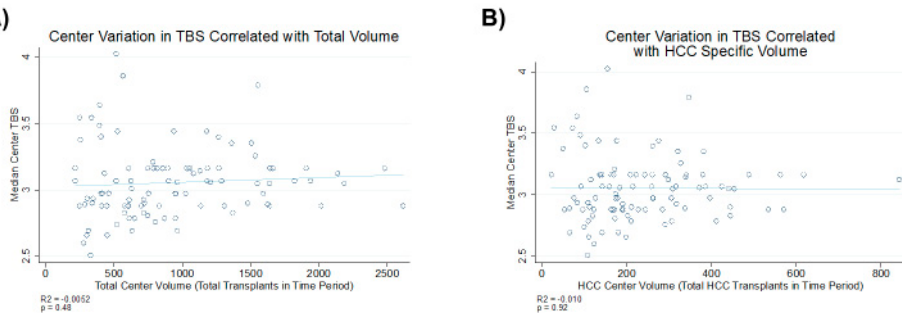
Figure 2. Correlation of the median TBS with ( A ) total transplant volume and ( B ) total hepatocellular carcinoma (HCC) transplant volume.